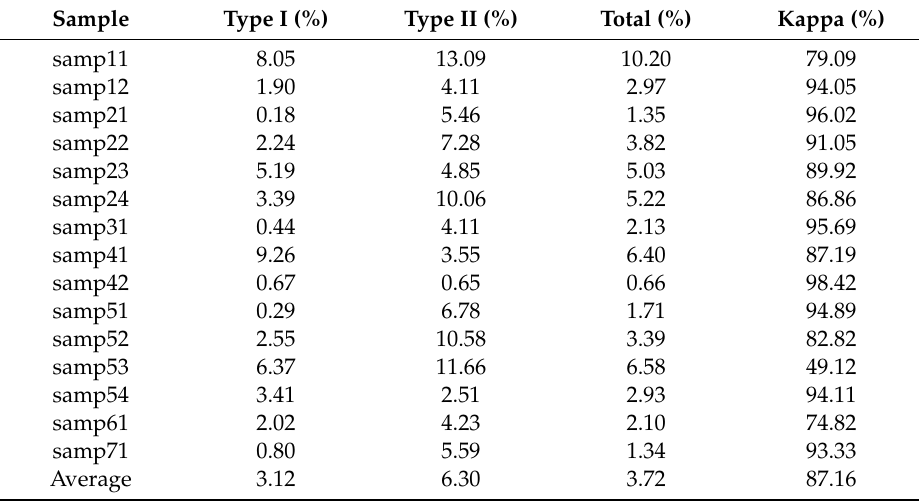
Table 1. Filtering accuracy for all the ISPRS